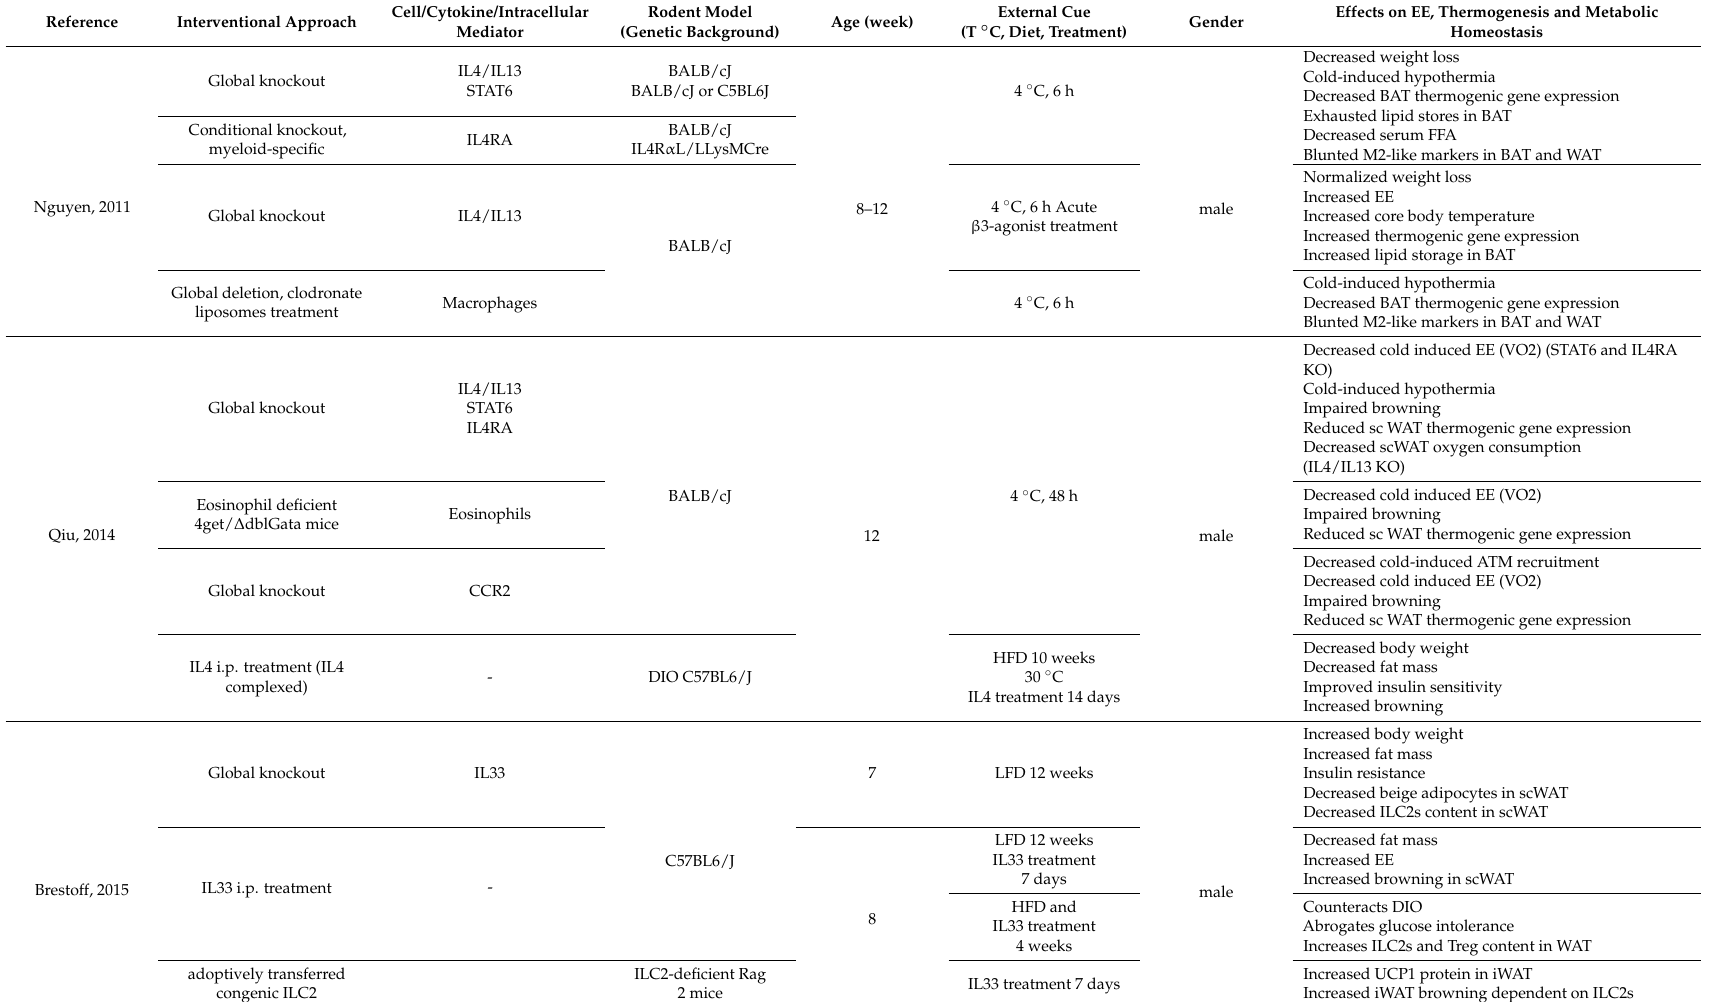
Table 1. Summary of cellular transfer, transgenic or pharmacological approaches targeting cytokine signalling with effects on BAT activity and beige fat